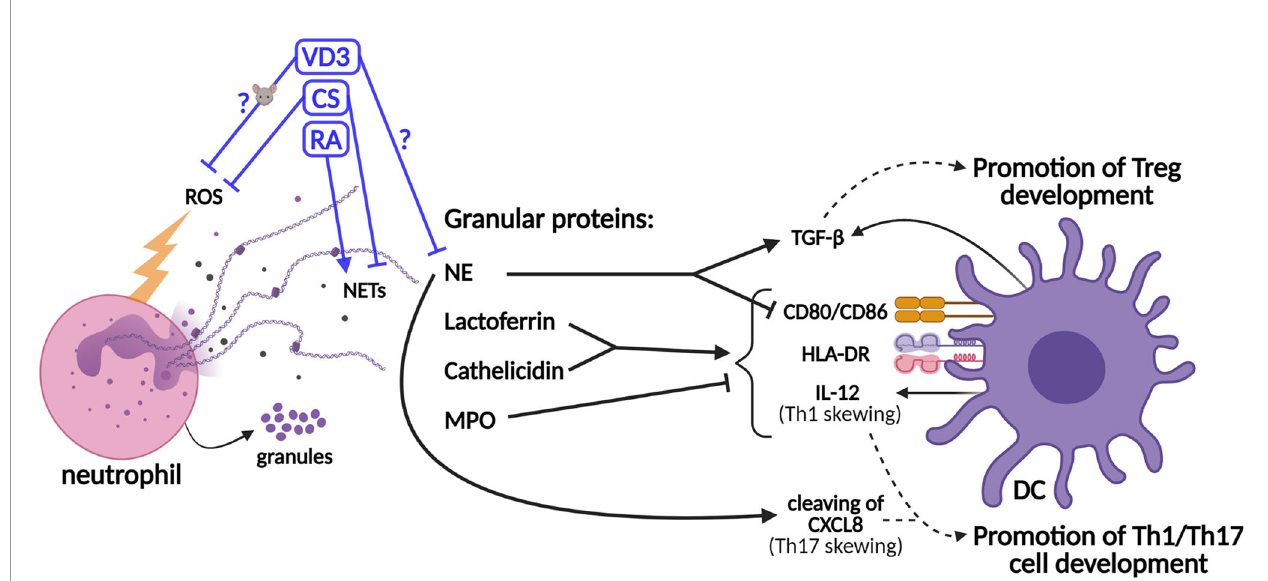
FIGURE 2 | Schematic representation of the effects of neutrophil granule contents on dendritic cell (DC)-driven T-cell development and the effects of tolerogenic adjuvants on the functions of neutrophils. Granule proteins released by neutrophils modulate T-cell development via direct effects on DCs. The production of the co- stimulatory molecules CD80/86, the major histocompatibility complex II (MHCII) molecule HLA-DR (human leukocyte antigen — DR isotype), and IL-12 cytokine is upregulated by lactoferrin and cathelicidin, while myeloperoxidase (MPO) inhibits this. Neutrophil elastase (NE) cleaves CXCL8, which promotes Th17 cell development. However, NE also stimulates the secretion of TGF- b by DCs and inhibits the expressions of CD80/86. TGF- b promotes the development of Tregs, while IL-12 and cleaved CXCL8 promote the development of Th1 and Th17 cells, respectively. The effects of vitamin D3 (VD3), corticosteroids (CS), and retinoic acid (RA) on the release of neutrophil extracellular traps (NETs) (or NE speci fi cally) and the generation of reactive oxygen species (ROS) are shown. The effects of VD3 and RA on (human) neutrophils are unclear and experimental data are